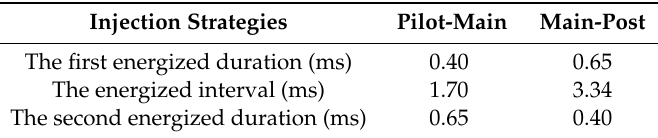
Table 3. Conditions for the